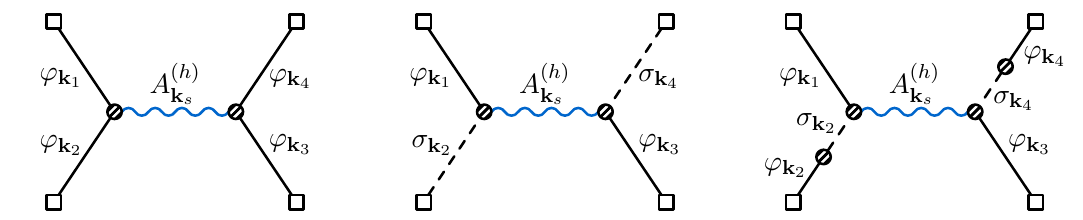
Figure 5 . The 4-point function mediated by a massive spin-1 boson A µ at tree